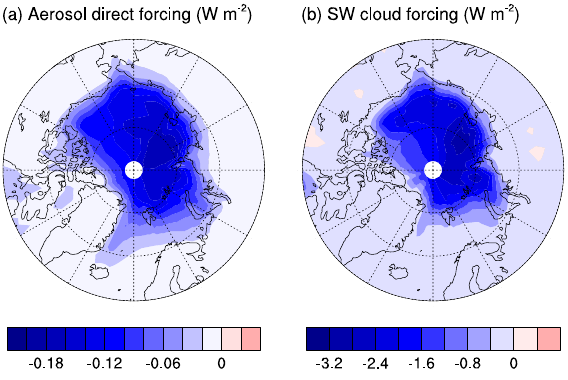
Fig. 15. Comparison of the average JJA modeled TOA natural aerosol direct radiative forcing and first natural aerosol indirect ef- fect derived from the difference between the P2 and P1